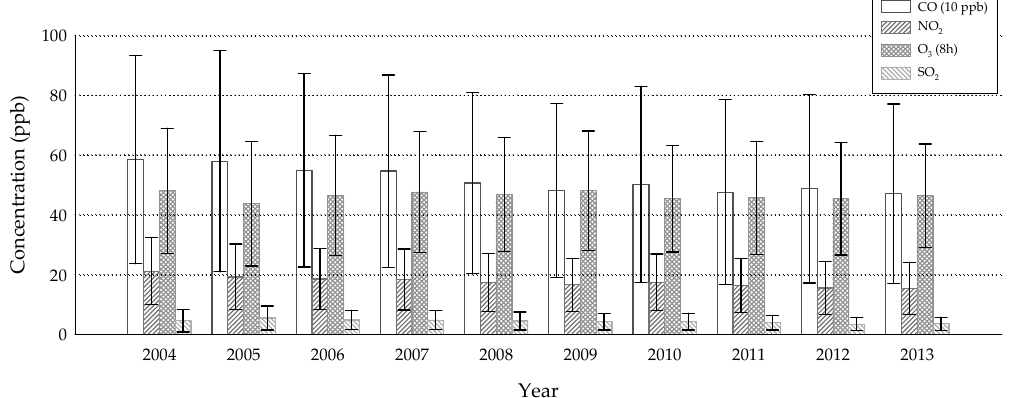
Figure 1. Annual mean concentrations of gaseous air pollutants (CO, NO 2 , O 3 , SO 2 ) from 2004 to 2013 (error bars denote standard deviations), derived from 73 of 76 monitoring sites.